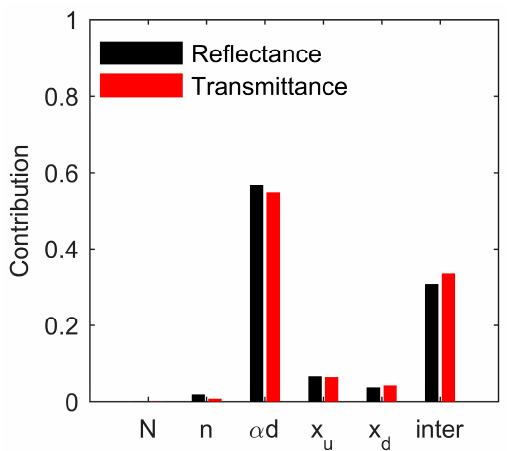
Figure 15. FAST first order sensitivity coefficients of the reflectance and transmittance of a particle string N . is the total number of particles, n is relative refractive index, α d is diametrical absorbance, x u and x d are particle backscattering and forward scattering ratios, inter denotes the interactions.